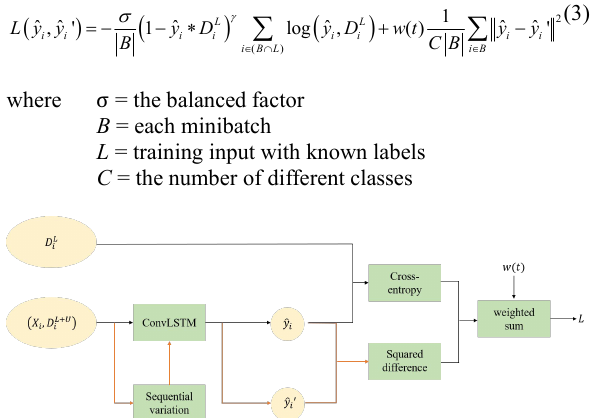
Figure 5. The process of semi-supervised learning and loss function